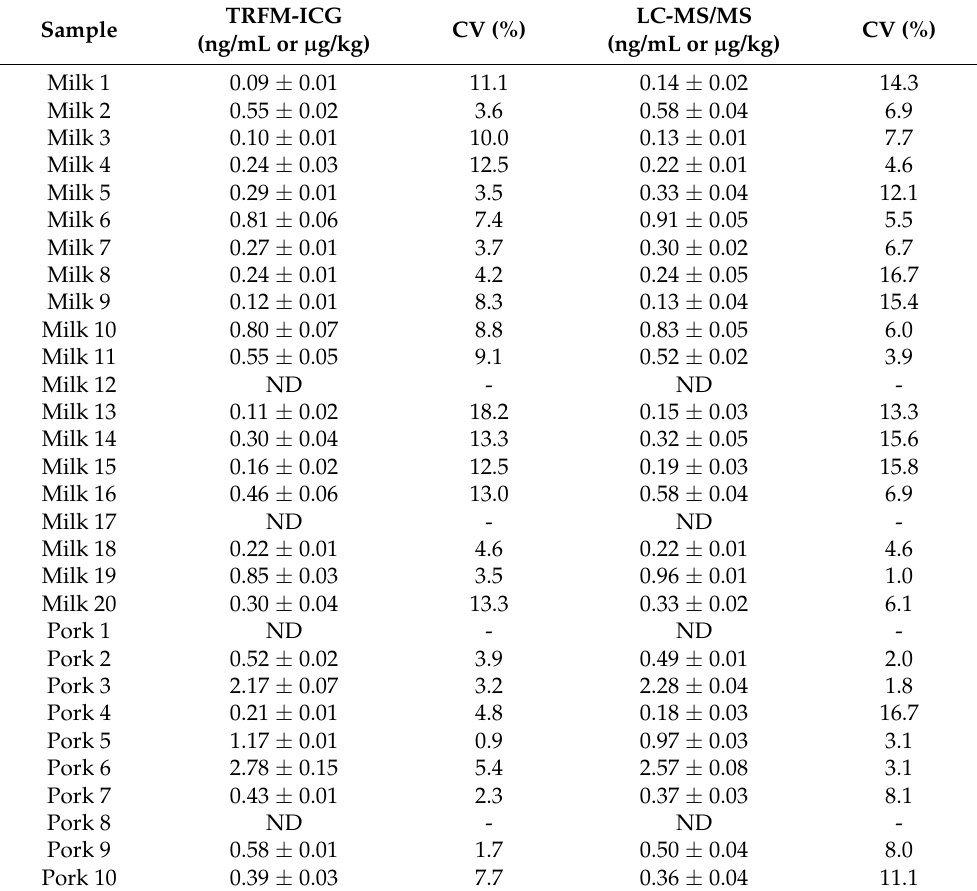
Table 2. Determination of DEX in blind milk and pork samples by LC-MS/MS and TRFM-ICG ( n =